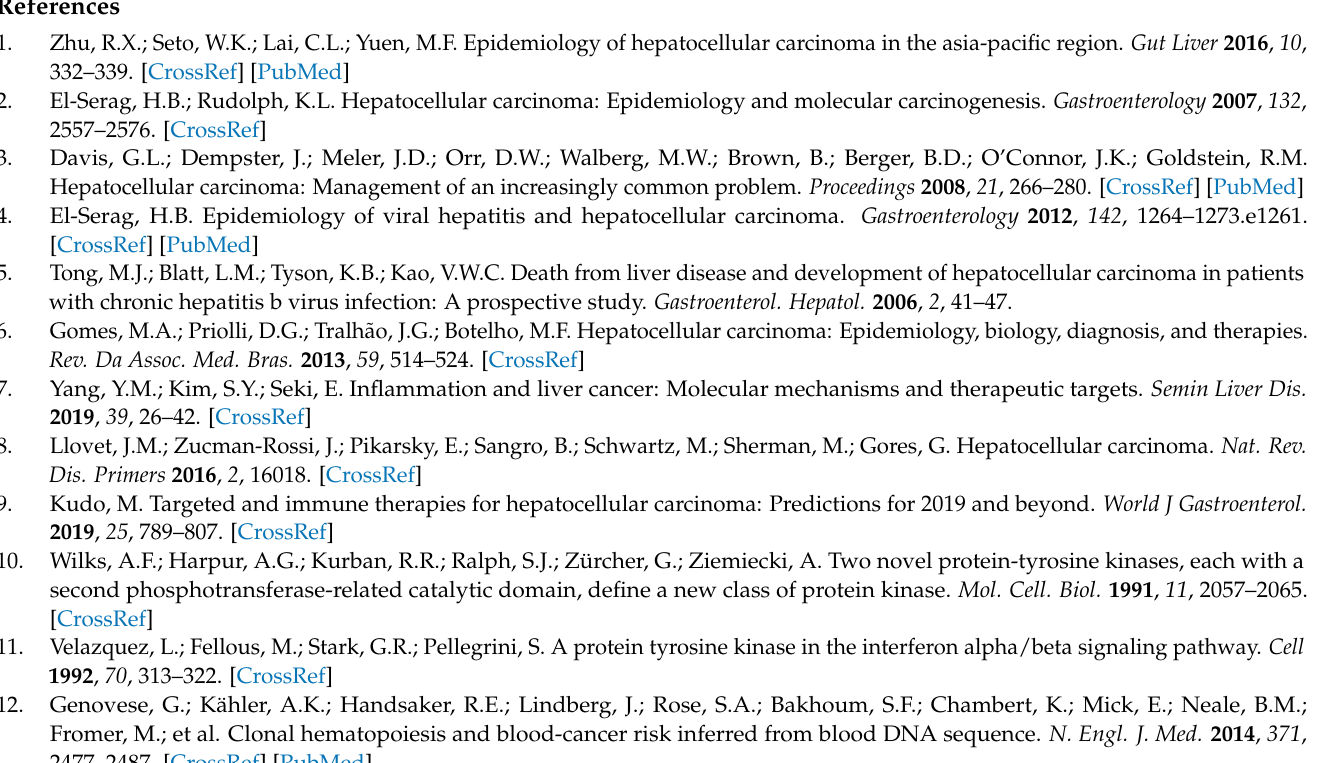
blots of Figure 2E, Supplementary Figure S7. Full-size blots of Figure 3D, Supplementary Figure S8. Full-size blots of Figure 4C, Supplementary Figure S9. Full-size